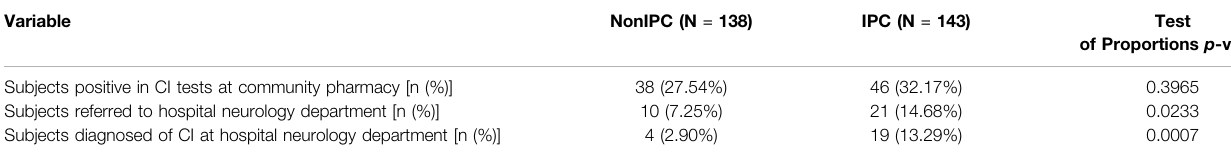
TABLE 4 | Statistical differences between both groups by using a test of proportions. Variable